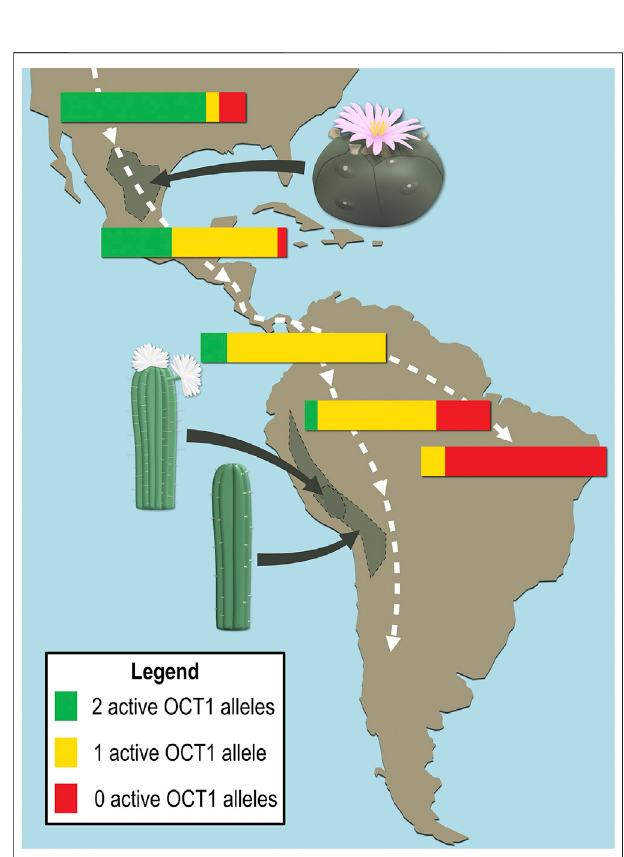
FIGURE 7 | Schematic representation of the frequency distributions of activeand inactiveOCT1allelesinlocalpopulationsandnaturalhabitatsofthe high mescaline-containing cacti Lophophora williamsii (peyote), Echinopsis pachanoi (San Pedro), and Echinopsis peruvianus (Peruvian torch). The white dashed lines broadly illustrate the migration pattern during the fi rst population of the continent by